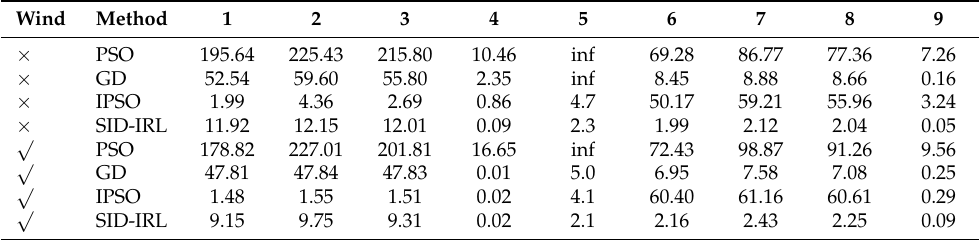
Table 7. Comparison results of case